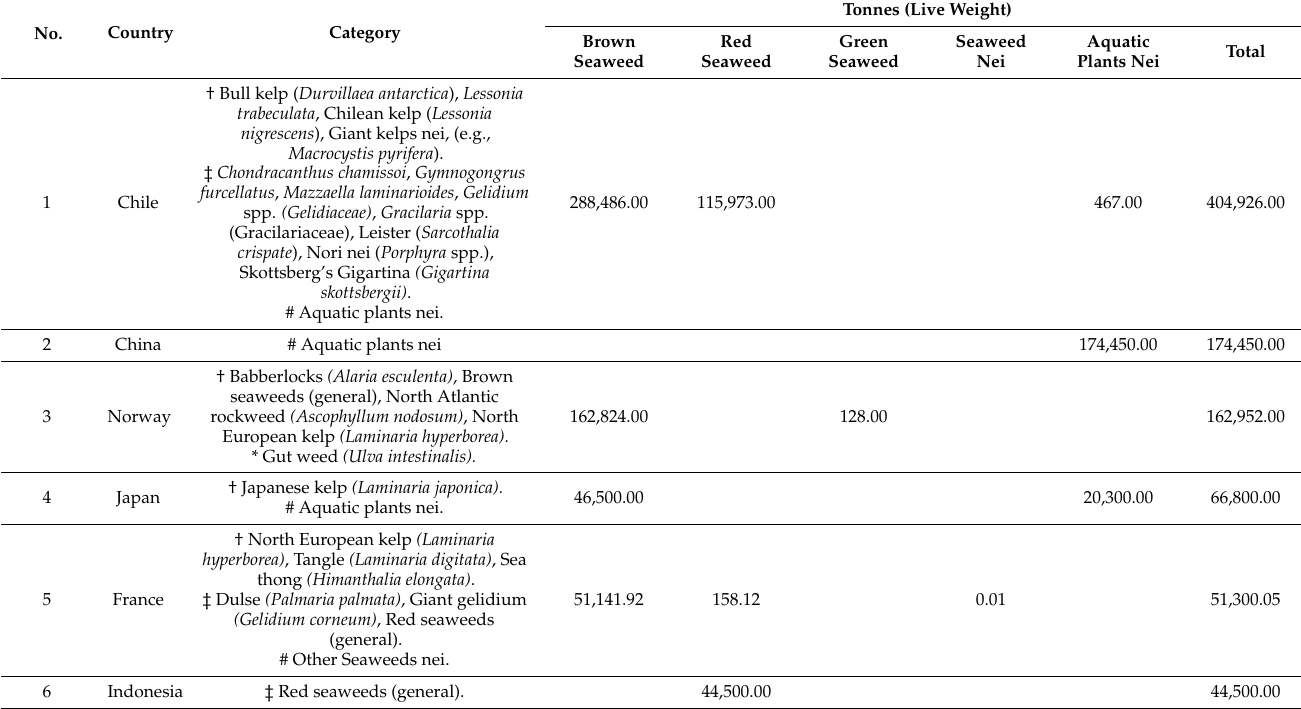
Table 1. Estimated wild seaweed and aquatic plants production worldwide in 2019, based on FAO global capture production statistics